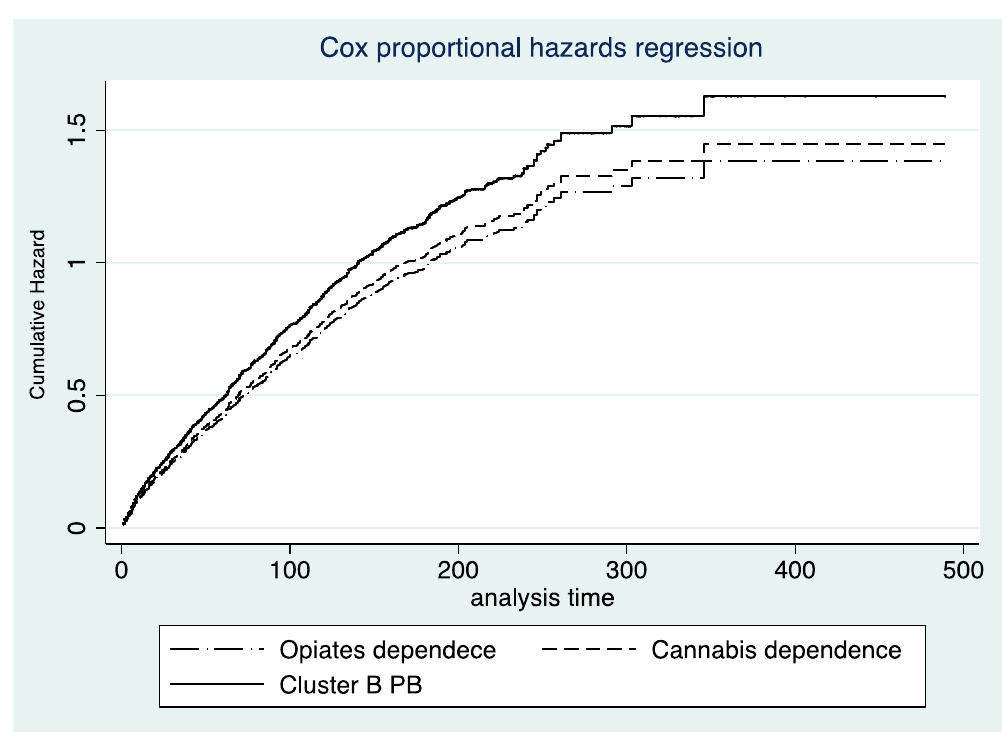
Figure 1. Treatment dropout risk according to patient